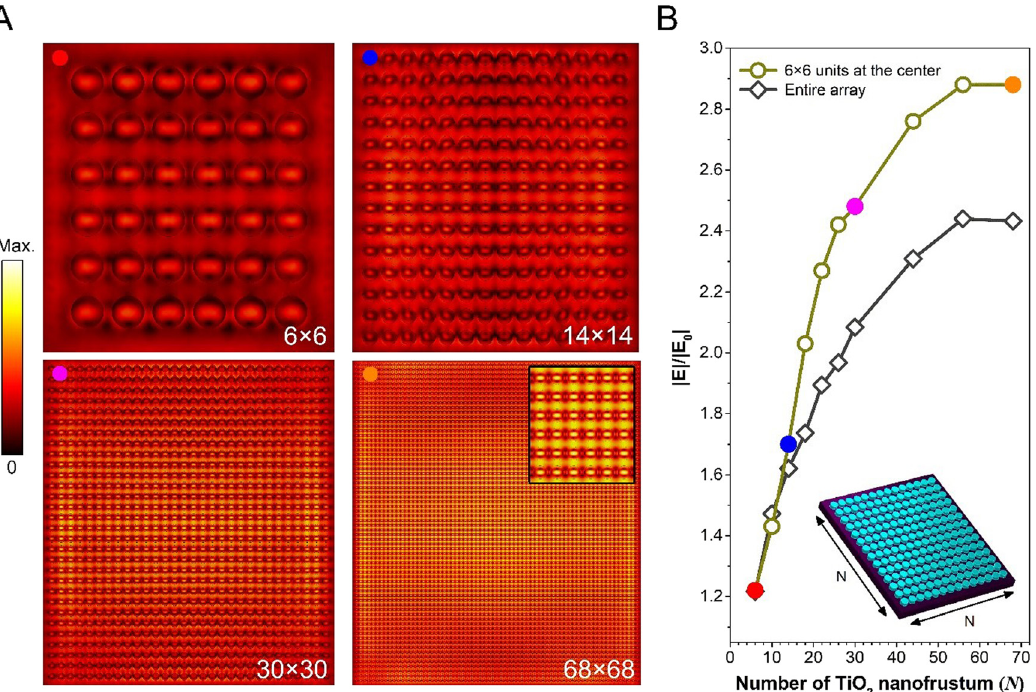
Figure 2: (A) Spatial electric field intensity distributions of four dielectric metasurface arrays in which each array consists of N × N TiO 2 nanostructures. Inset in the 68 × 68 array shows a zoom-in image for clarity. The corresponding electric fi eld enhancements at the center of each array are shown in (B).(B) Electric fi eld enhancement versusthe metasurface array size. The fi eld enhancements are respectively carried out from a fi xed area (6 × 6 nanostructures at the center of individual array) and the entire array for comparison. The electric intensity is normalized to the intensity of incident wave ( E 0 ). Inset: schematic of an N × N metasurface